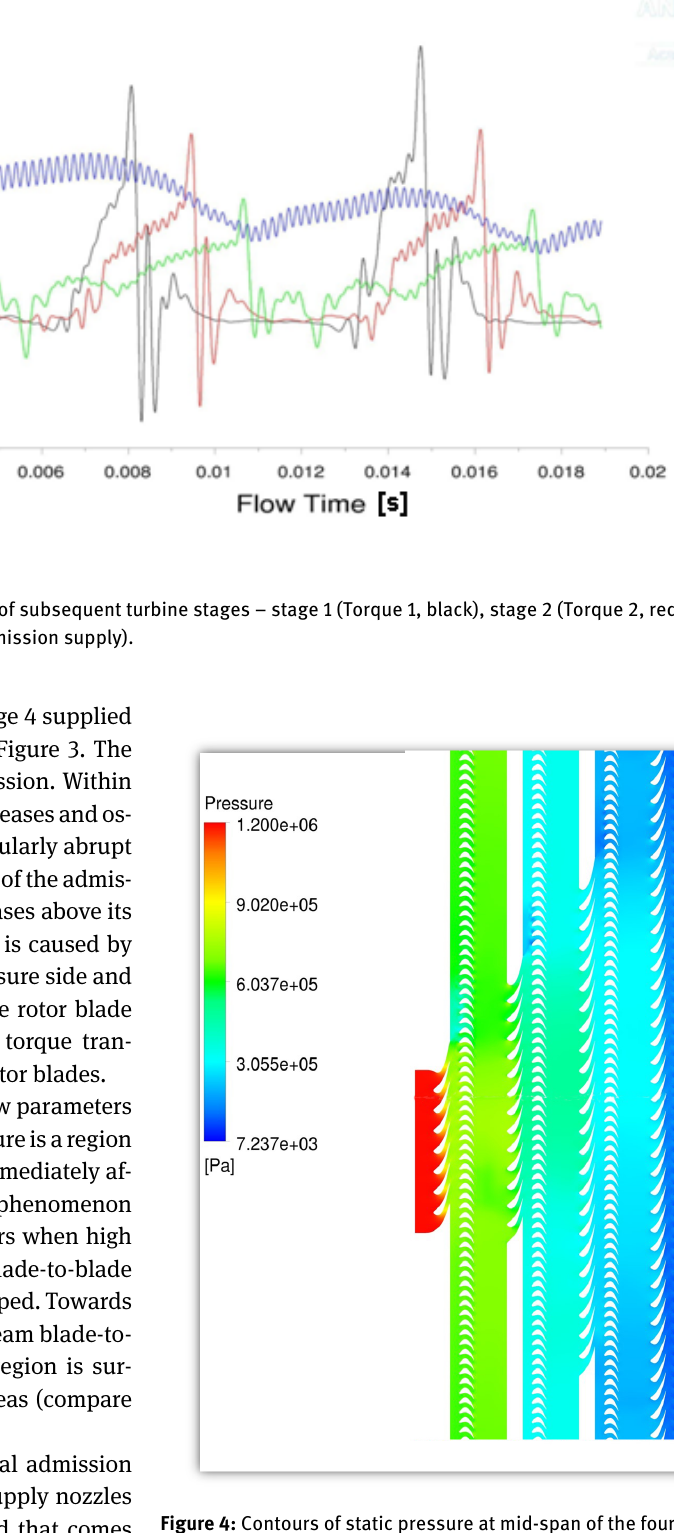
Figure 4: Contours of static pressure at mid-span of the four stages of the ORC